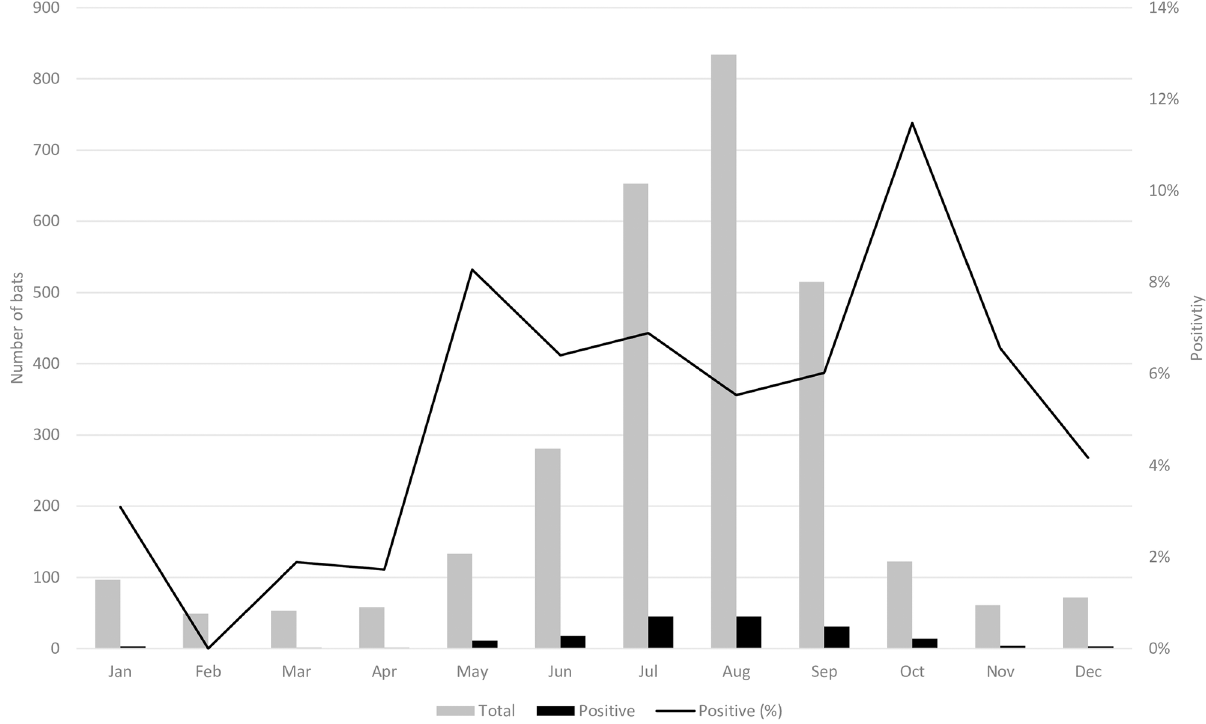
Fig 1. Numbers of identified bats with definitive RABV test results (N = 2,928) and RABV positivity by month, Washington State—2006–2017.